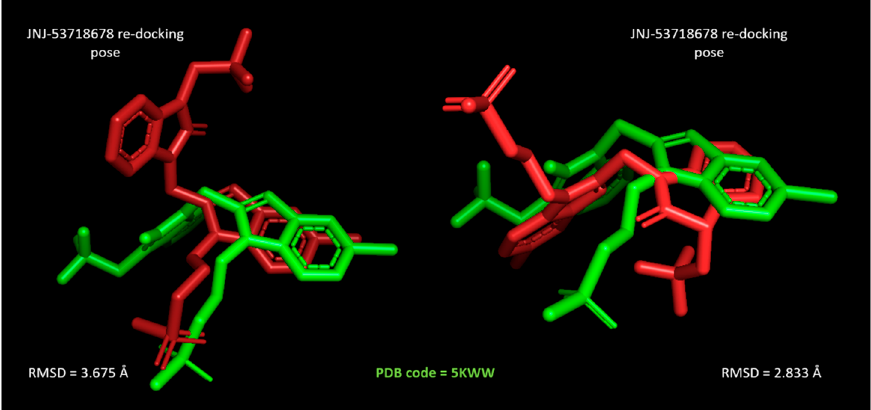
Figure 11. Comparison of the best scored JNJ-53718678 docking pose (red ligand) with respect to the same crystallized compound at the 5KWW PDB code (green ligand) by LeadIT molecular docking ( left side ) and by MOE Dock calculation ( right side ). RMSD values were evaluated by Pymol [35].